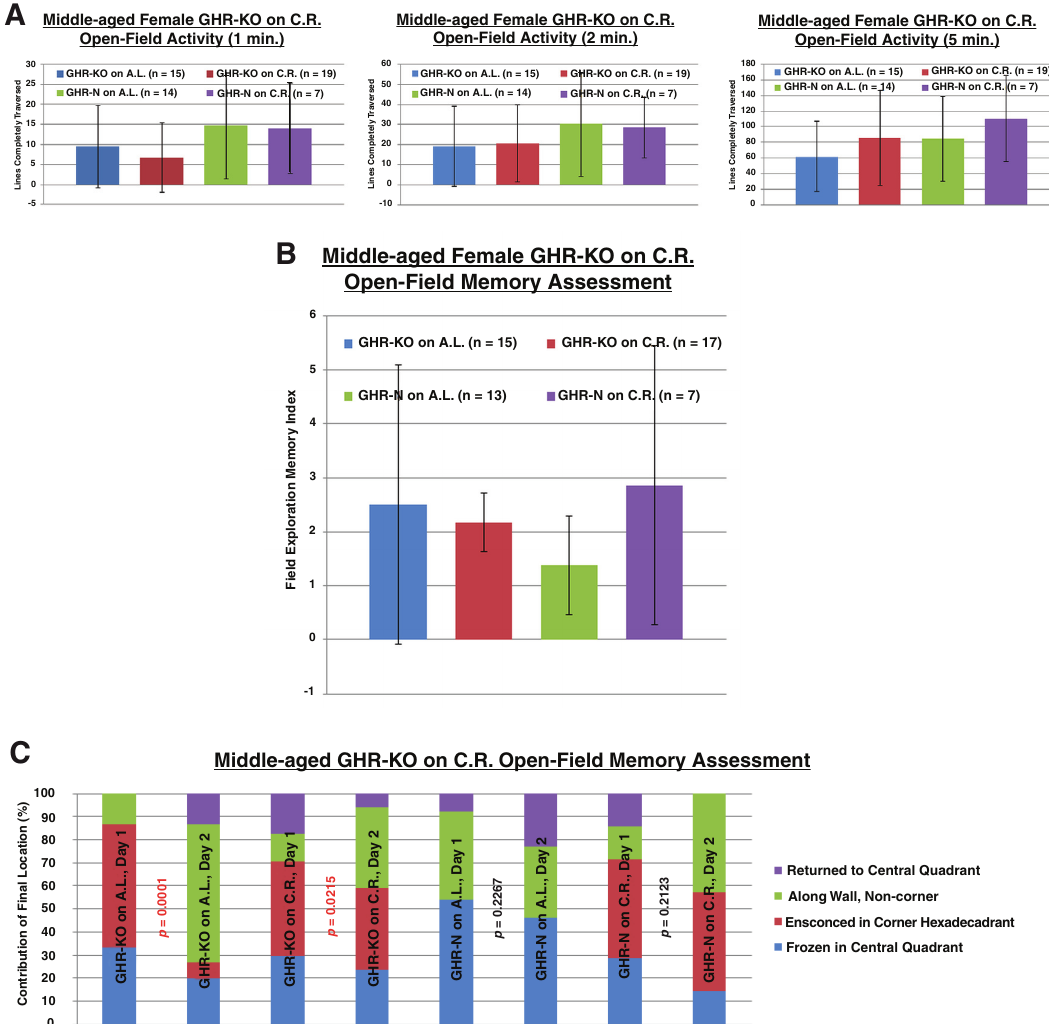
Figure 3. Failure of 30% caloric restriction to influence cognition. A. Neither Ghr/bp disruption nor 30% caloric restriction alters anxiety- betraying activity in an open field for female mice. B. 30% caloric restriction does not change the (memory index) performance of female GHR-KO mice in the open-field paradigm. C. 30% caloric restriction does not change the (final location) performance of female GHR-KO mice in the open-field